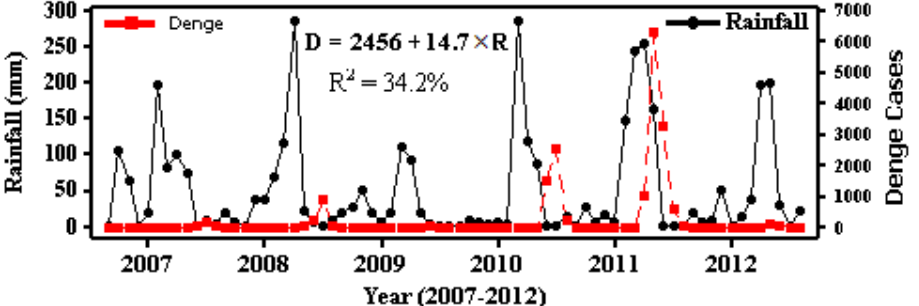
Table 3. Monthly ordinary linear regression analysis of dengue versus rainfall.